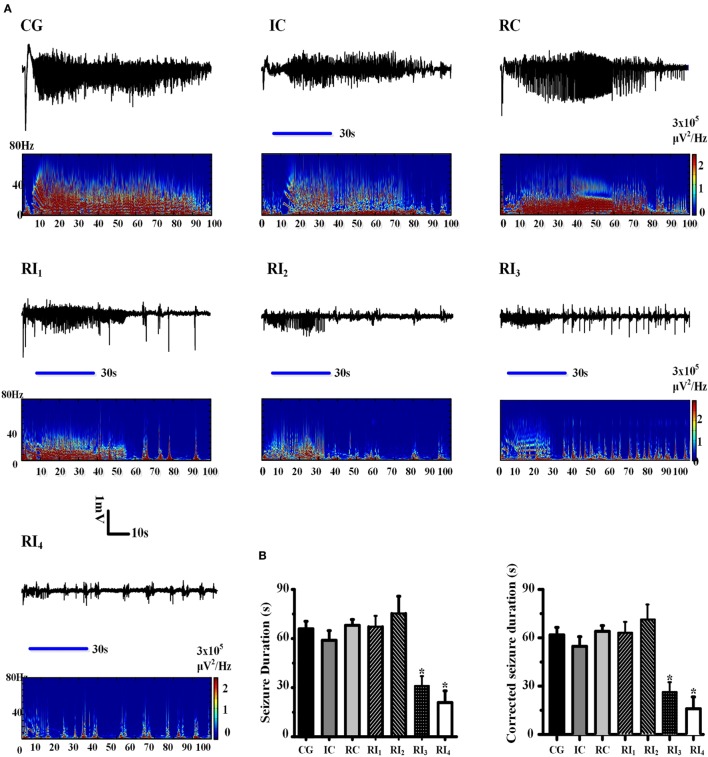
Uncaging of ruthenium-bipyridine-triphenylphosphine-c-aminobutyric acid reduced 4-aminopyridine (4-AP)-induced neocortical seizures. (A) The top panel of each group shows the electroencephalogram (EEG) record which demonstrates the seizure duration for each group. Morlet-wavelet EEG spectra from the seizures which were induced by 4-AP for each group are shown. The blue horizontal line shows the beginning and end points of the period of illumination. (B) Comparison of seizure durations among experimental groups. The duration of seizures was significantly shorter in the RI3 and RI4 groups compared with the control group (*P < 0.05).